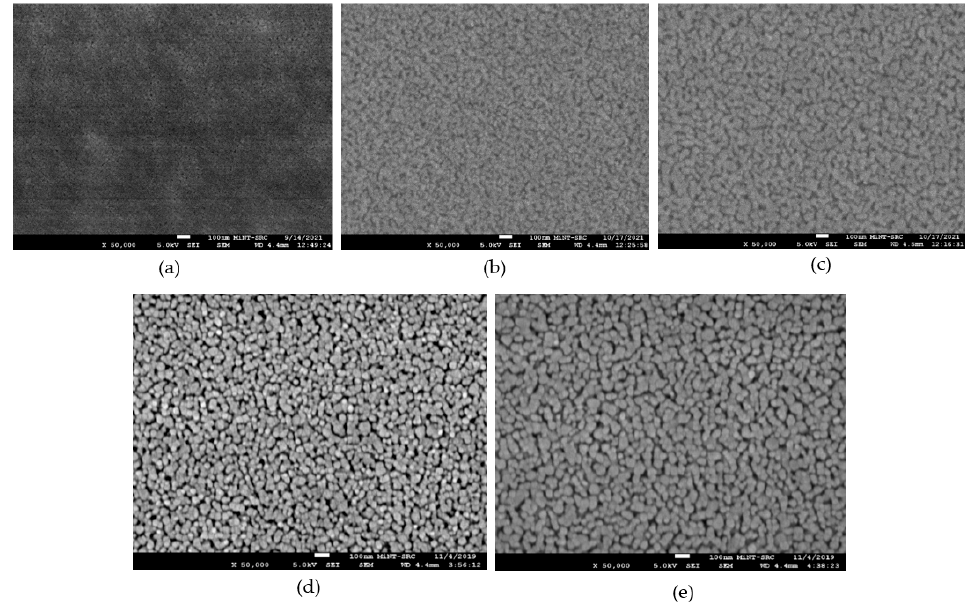
Figure 2. FE-SEM images of top view of ( a ) n-TiO 2 /FTO substrate annealed at 600 °C for 1 h, n- TiO 2 /ZnO bilayer thin films annealed for ( b ) 1, ( c ) 1.5, ( d ) 2, and ( e ) 2.5 h at 500 °C, respectively.